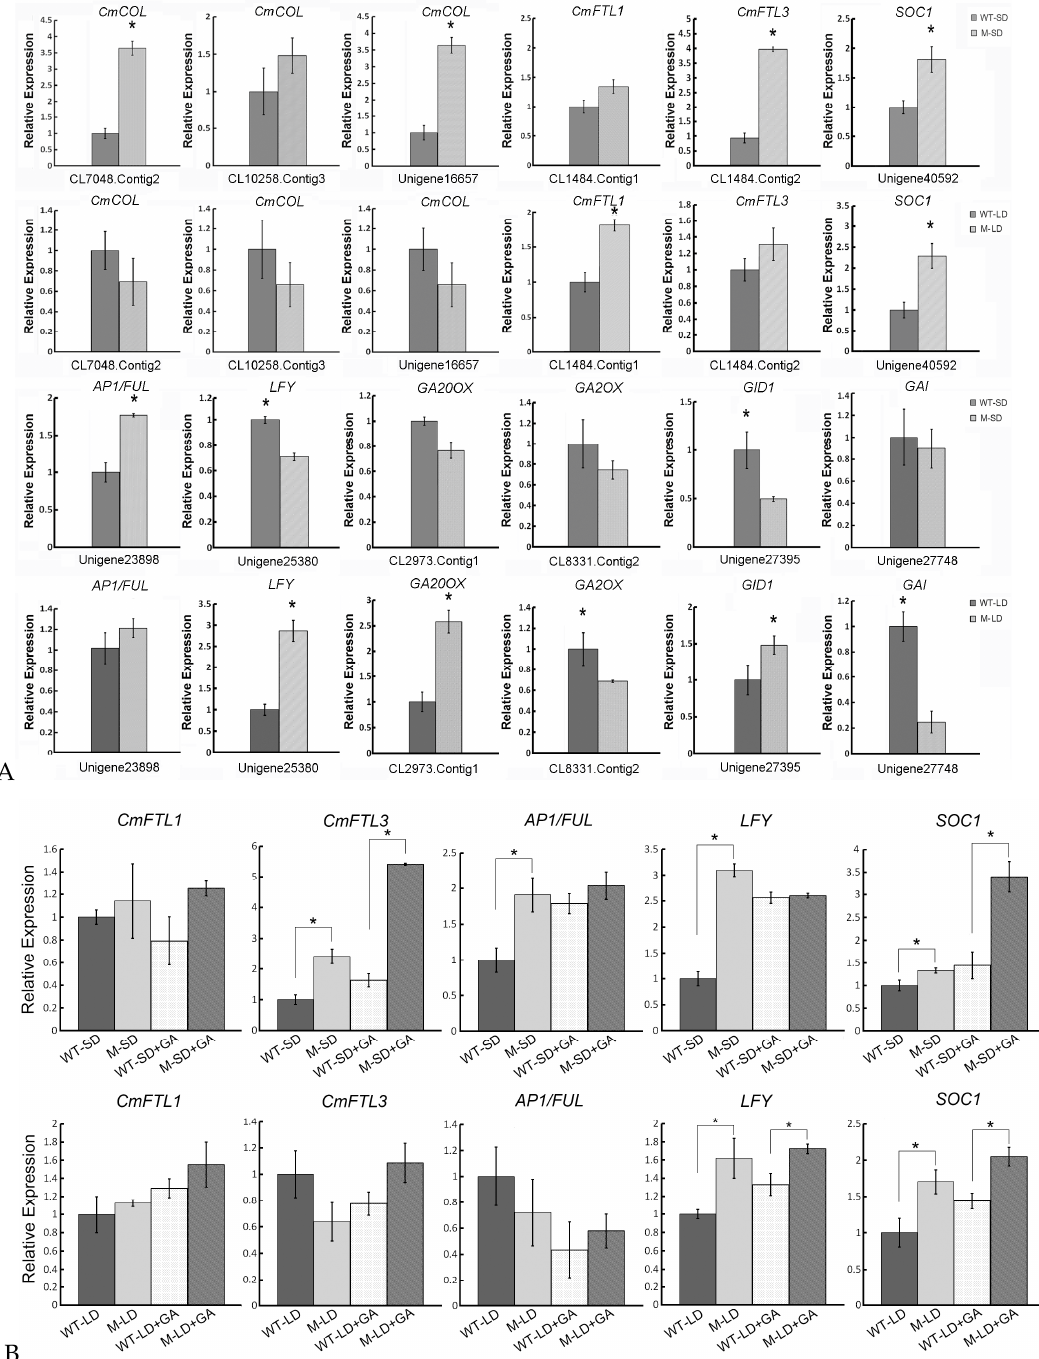
Figure 4. Transcription of key flowering-related genes using qRT-PCR. ( A ) Relative transcript abundance in WT and M plants grown under LD or SD; ( B ) Relative transcript abundance in WT and M plants sprayed with GA and grown under LD or SD. * indicates significantly different expression level between two samples. Student’s t test ( n =